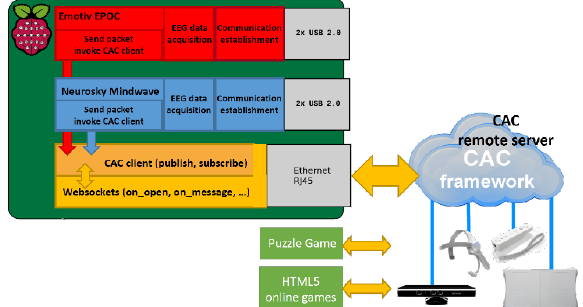
Figure 1 Neuroberry architecture. Each color represents a separate thread.